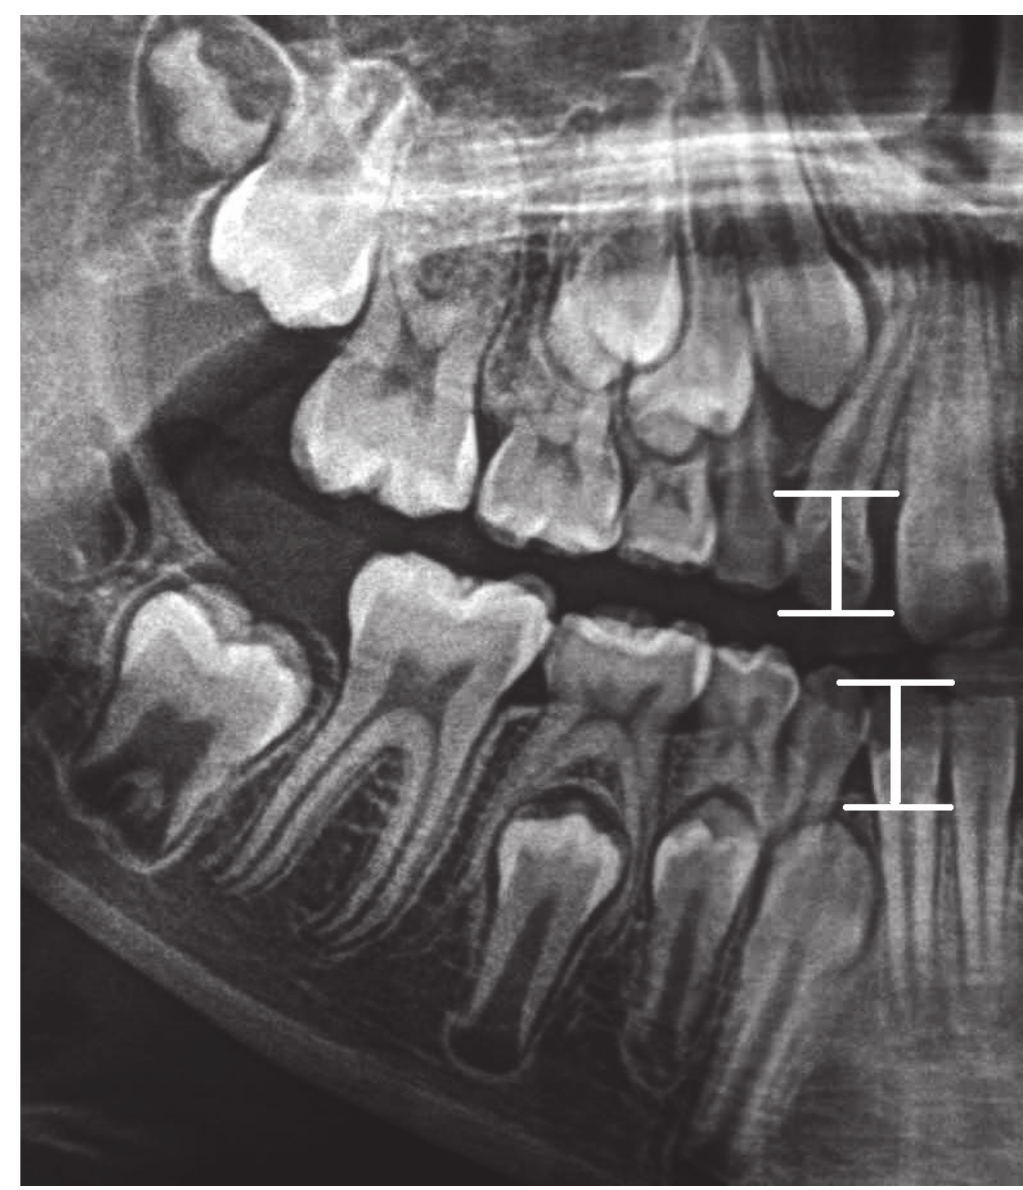
Figure 3. Graphic representation of the S12-W12 and S 42-W42 distances. S13-W13 is the distance between point S13 (on the incisal margin of tooth 13) from point W13 (the point on the alveolar margin in the line drawn through the point on top of the alveolus perpendicular to the X